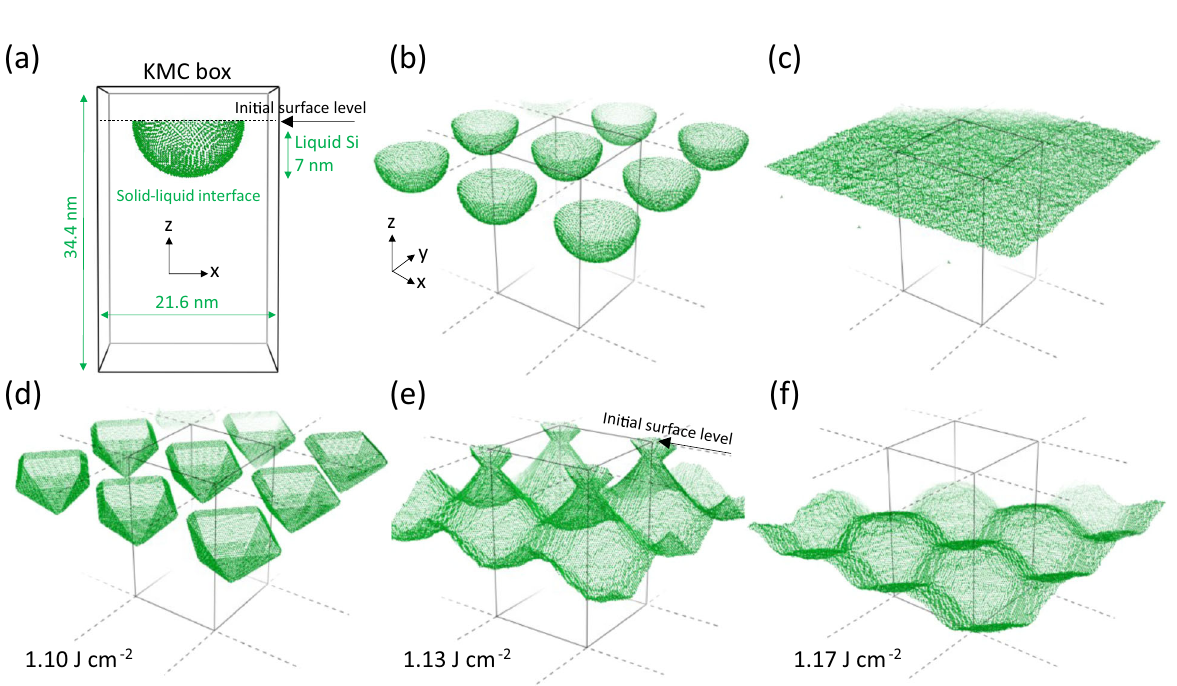
Fig. 8 FEM-KMC simulations of Si(100) laser annealing in the inhomogeneous nucleation case. a KMC periodic box used for the LA simulations with inhomogeneous nucleation, showing the solid – liquid interface in green, embedding liquid Si. The black arrow indicates the initial surface level. b KMC box periodically extended along x and y , highlighting the regular distribution of the initial nuclei. For convenience, here and in the following panels the top side of the box has been moved to the initial surface level. c Initial solid – liquid interface in the KMC box in case of homogeneous nucleation. d Melting front after 41 ns of irradiation at fl uence 1.10 J cm − 2 , corresponding to the time of maximum melt volume during the FEM-KMC simulation. e Melting front after 37 ns of irradiation at fl uence 1.13 J cm − 2 ( f ) Melting front after 32 ns of irradiation at fl uence 1.17 J cm − 2 . See also Supplementary Movies 2 –